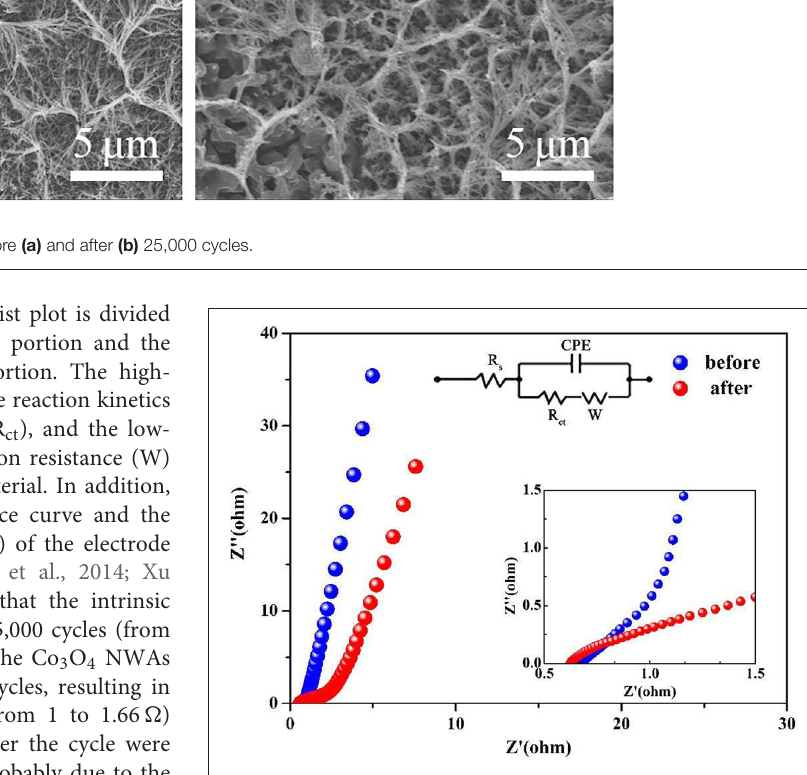
curve results. A specific capacity of 162 C g − 1 at 0.2 A g − 1 of the